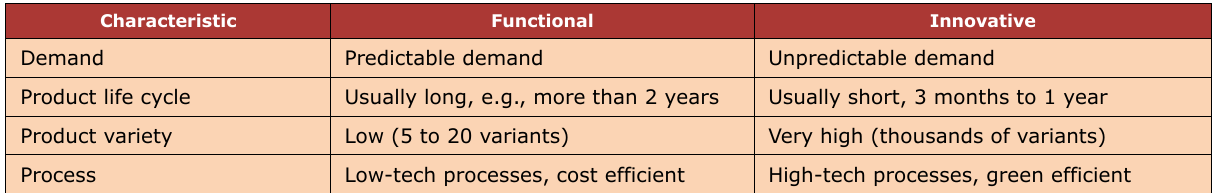
Table 3. An analysis of functional versus innovative product